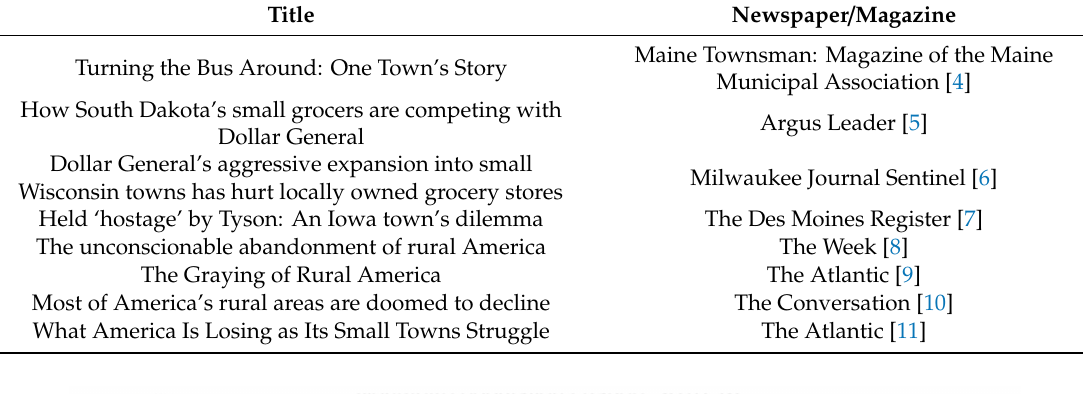
Table 1. Example newspaper and magazine article titles.